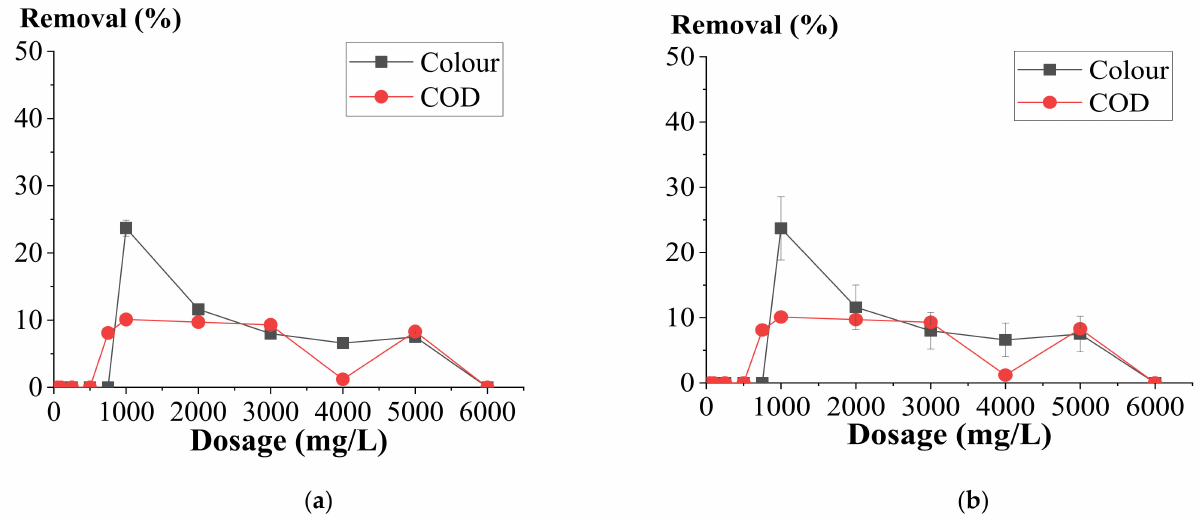
Figure 4. Influence of dosage on the removal of colour and COD using ( a ) Rubber Seed (RS) (1000–10,000 mg/L), ( b ) Polyacrylamide (PAM) (100–6000 mg/L) at pH